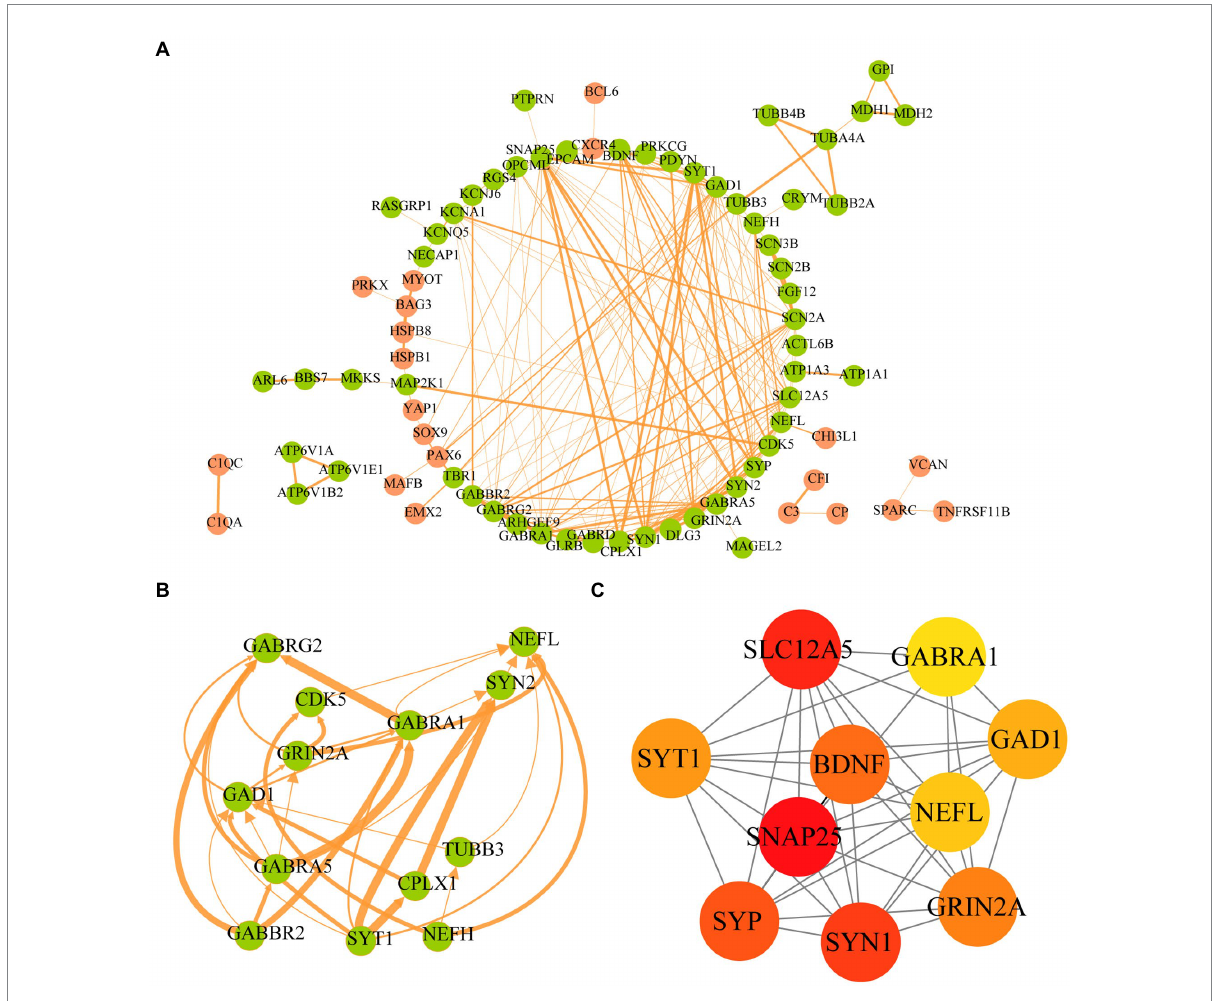
FIGURE 6 Protein–protein interaction network of AD-related DEGs and screening of hub genes. (A) The STRING database is used to construct the PPI network of AD-related, with 77 nodes and 198 edges. The upregulated genes are shown in orange and the downregulated genes are shown in green. The wider the edge, the higher the combined score. (B) The gene cluster with the highest score of AD-related DEGs PPI network. (C) The top10 hub genes constructed by the MCC method using Cytohubba